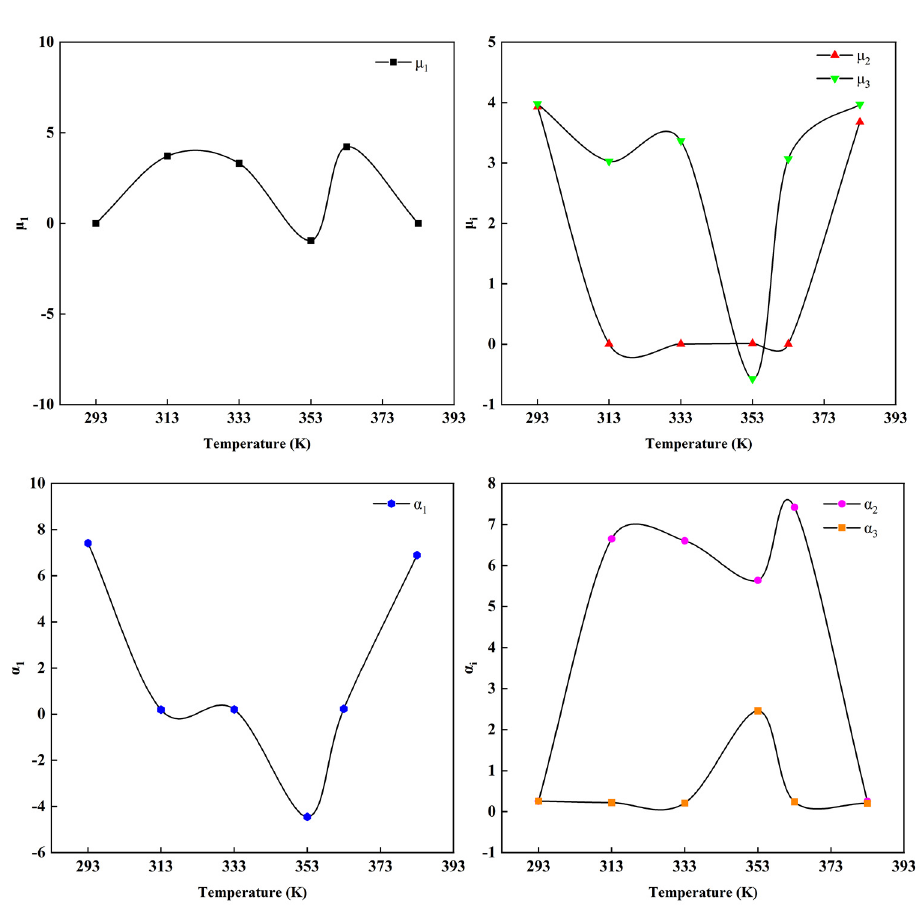
Figure 4. Trend of parameters for the uniaxial tensile data of the C20 rubber specimen at different temperatures by the Ogden constitutive model ( N = 3).